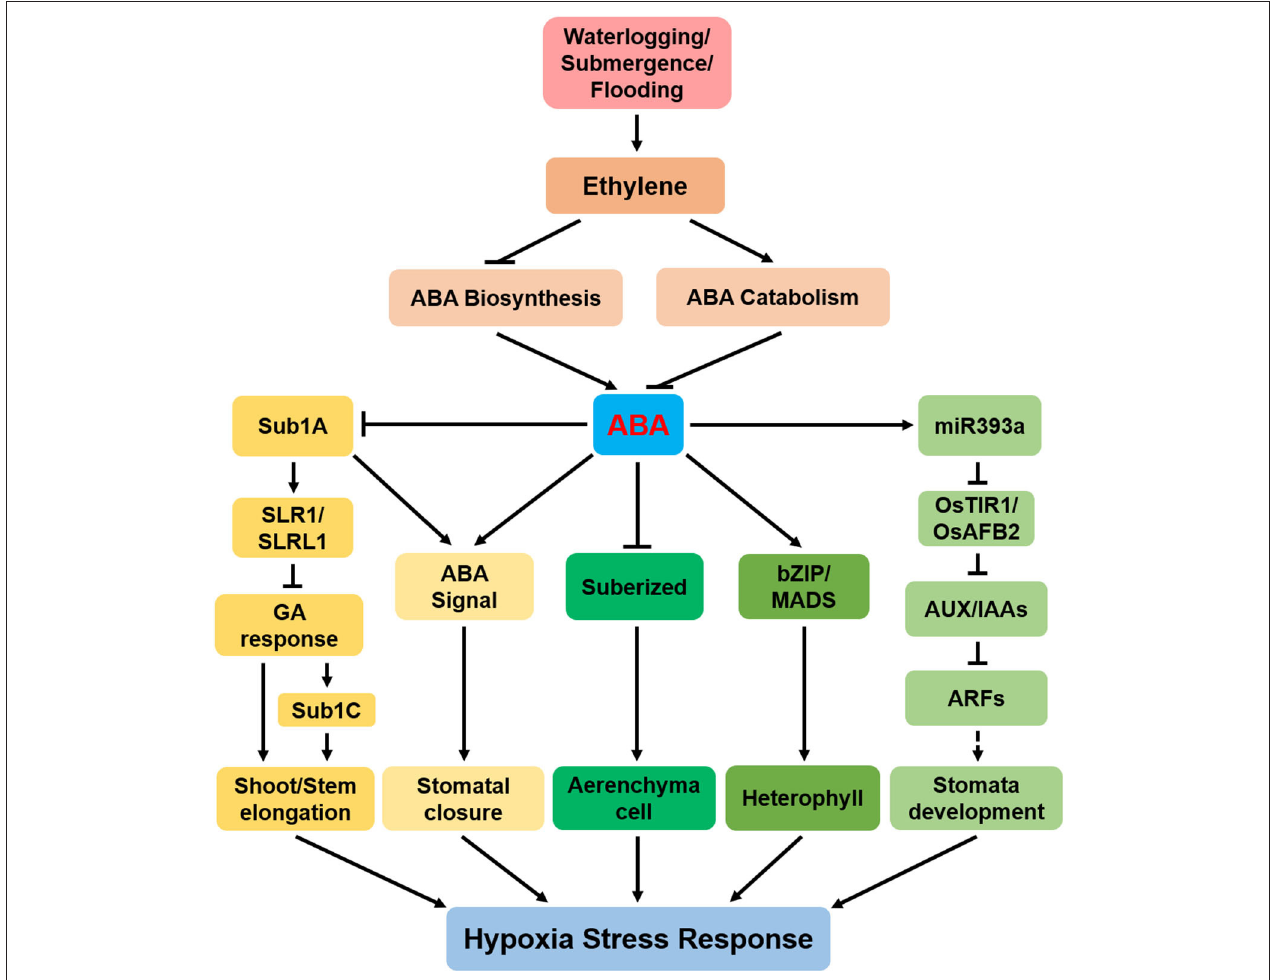
FIGURE 1 | A model showing that abscisic acid (ABA) regulates hypoxia stress response. Submergence, waterlogging, and flooding cause hypoxia, which leads to ethylene accumulation. Ethylene positively regulates ABA catabolism and negatively regulates ABA biosynthesis, thereby affecting ABA content. ABA affects tolerance of plant hypoxia through the following pathways: (1) ABA negatively regulates submergence1 A ( Sub1A) expression. Sub1A promotes the accumulation of two gibberellin (GA)-negative regulators [SLENDER RICE 1 (SLR1) and SLENDER RICE-LIKE 1 (SLRL1)] and then directly promotes shoot elongation; (2) ABA